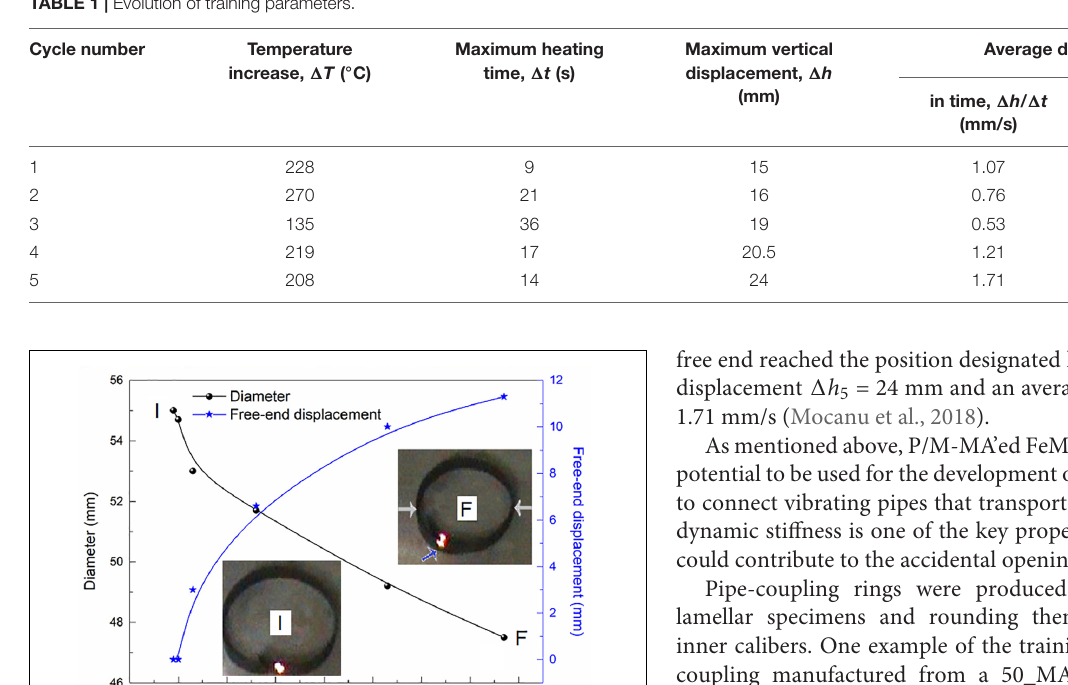
FIGURE 13 | Free-recovery SME training of a 40_MA_1000 lamellar specimen subjected to bending: (a) the start of 1st cycle; (b) the end of 5th cycle (reproduced after Mocanu et al., 2018, with permission granted by Springer Nature). TABLE 1 | Evolution of training parameters.